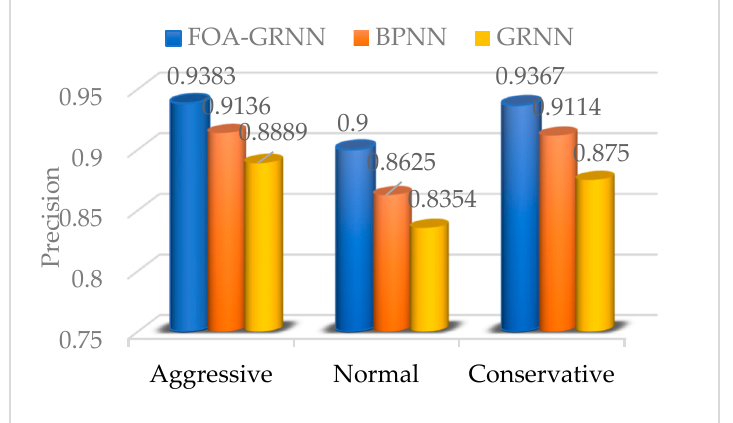
Figure 12. Precision comparison of the FOA-GRNN, BPNN and GRNN identification models.